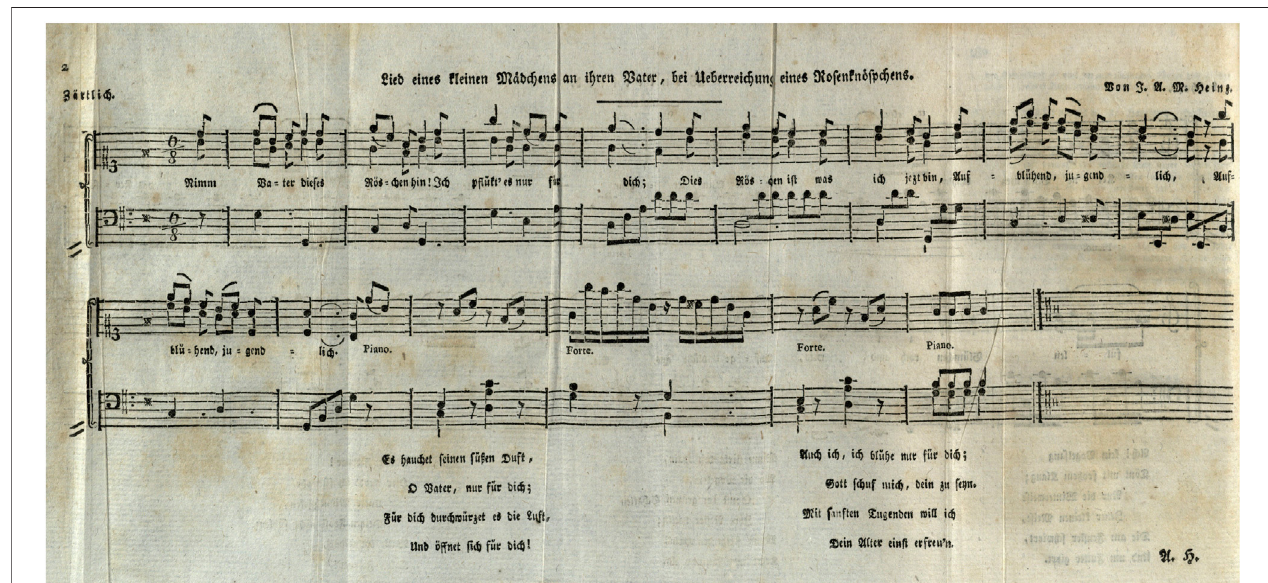
FIGURE 3 | Heinz, “ Lied eines kleinen Mädchens an ihren Vater, bei Ueberreichung eines Rosenknöspchens ” (text: “ A. H. ” ), from Amaliens Erholungsstunden (1791:2.1, after 286). With the kind permission of the University and City Library of Cologne. Shelfmark 2C9064-1791,1/2.